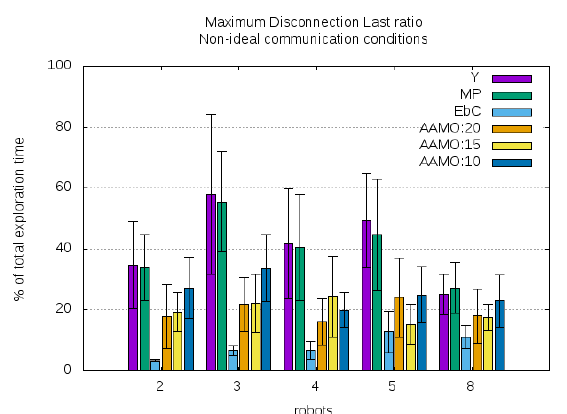
Figure 27. Maximum Disconnection Last Ratio (MDLR) under non-ideal communication conditions. MDLR shows the longest individual isolation period registered by some fleet member along the exploration. The trend is oscillatory following the same pattern as the DLR